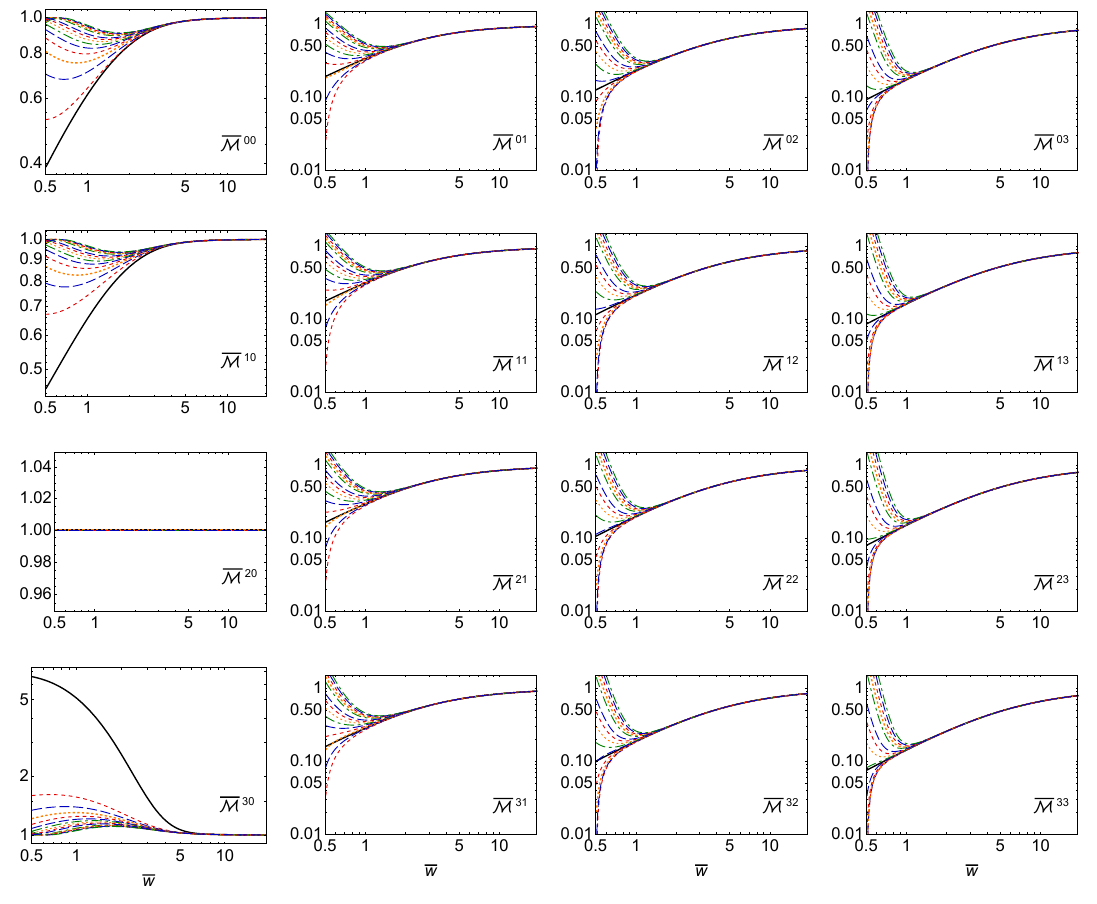
Figure 1 . Scaled moments M nm obtained from the exact attractor solution (solid black line) compared to a set of exact solutions (various colored dotted and dashed lines) initialized at (cid:28) = 0 : 1 fm/c with varying initial pressure anisotropy. The horizontal axis is w (cid:17) (cid:28)=(cid:28) eq = (cid:28)T= 5(cid:22) (cid:17) . Panels show a grid in n and m